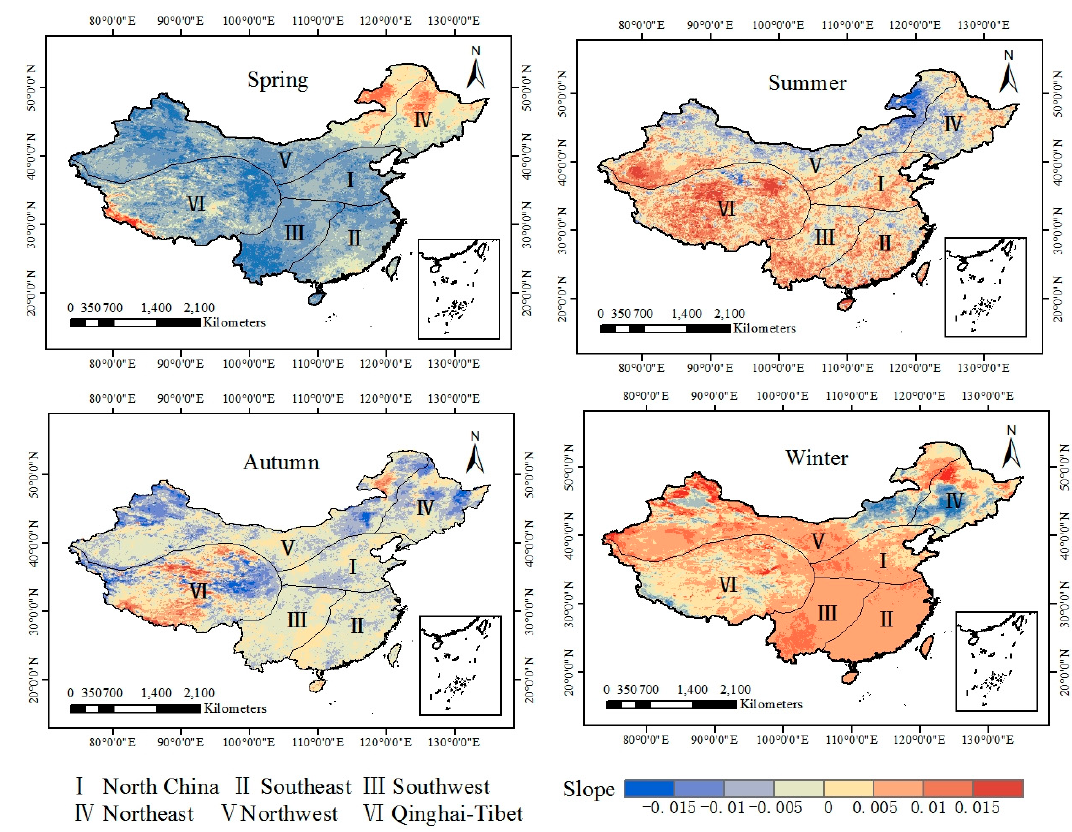
Figure 11. Slopes of the seasonal average LST from 2003 to 2018